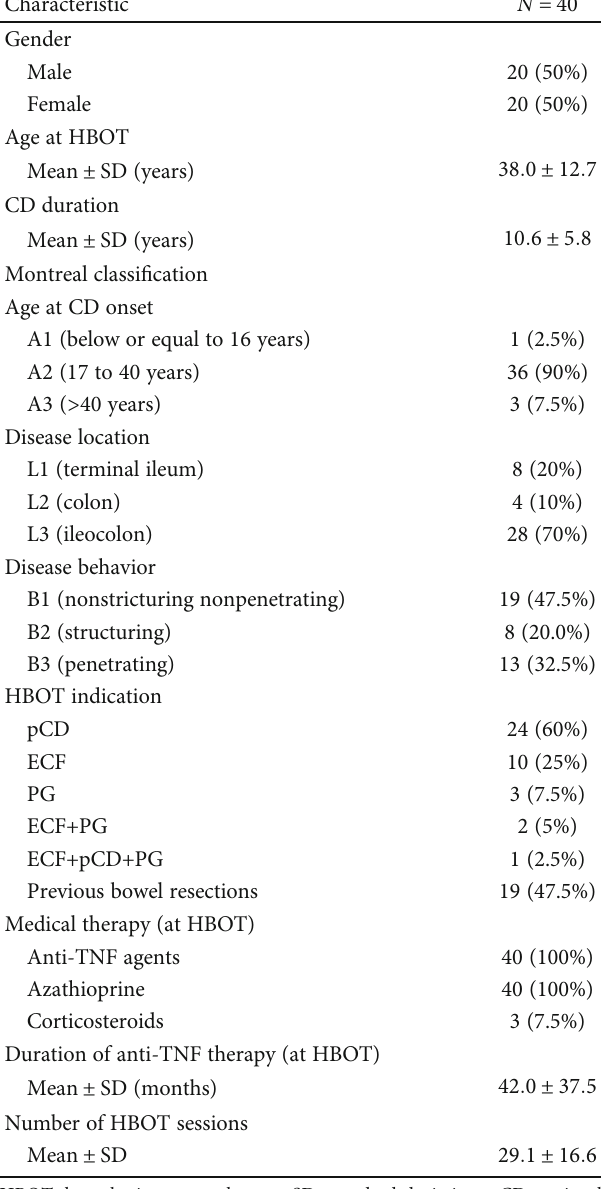
Table 1: Baseline characteristics of patients and